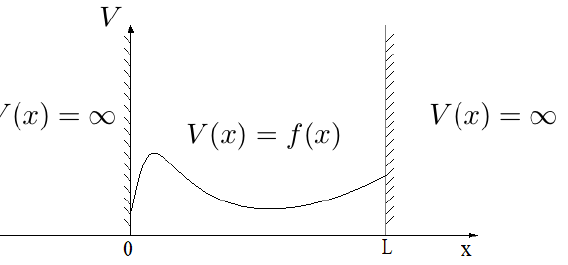
Figure 2. Sketch of the quantum mechanical bound state problem, where a particle is constrained in a finite sized box, with a V ( x ) potential